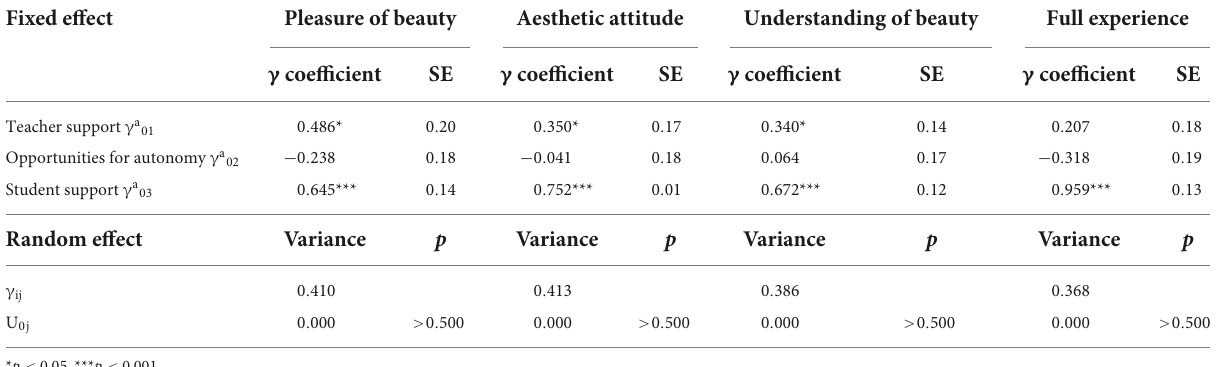
TABLE 4 Summary of hierarchical linear modeling analysis of learning environment and aesthetic experience.